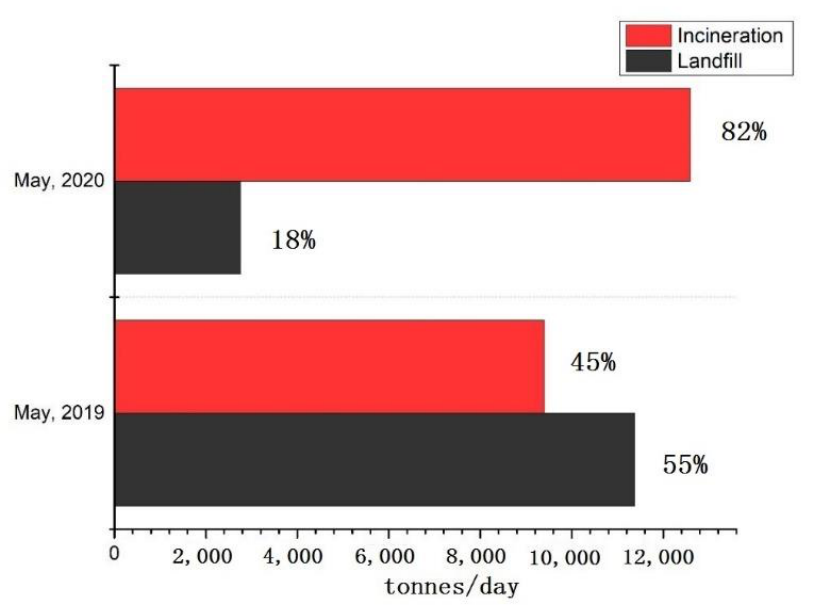
Figure 3. The proportions of different disposal treatment types for residual waste in Shanghai before and after the July 2019 law. There was also a compositional change: water content for both treatments became reduced after July 2019 due to the diversion of (wet) food waste [28].